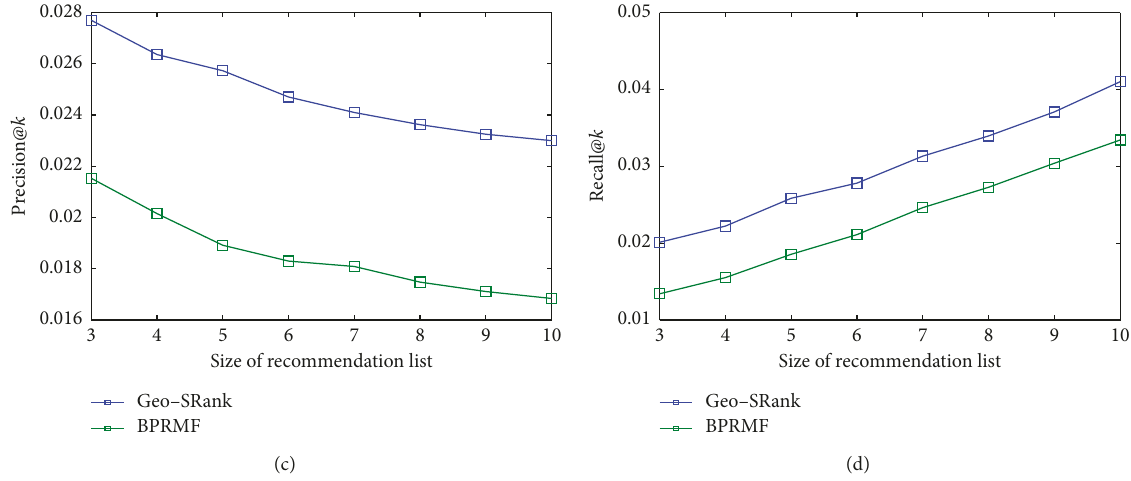
Figure 7: Experimental results with different recommendation numbers. (a, b) Gowalla and (c, d) Yelp.